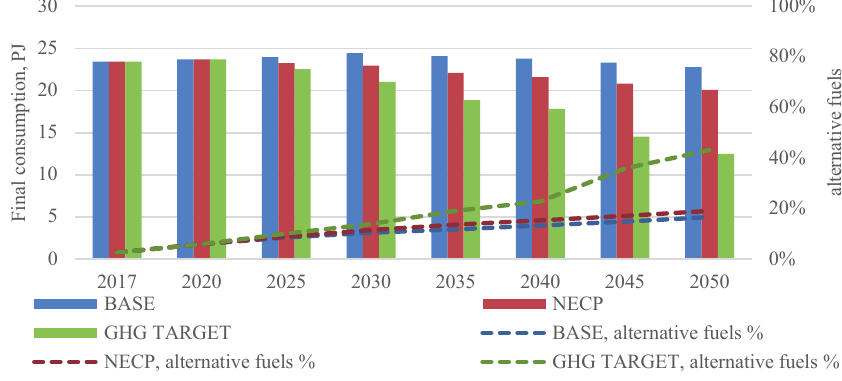
Fig. 8. Fuel consumption for land passenger transportation for alternative